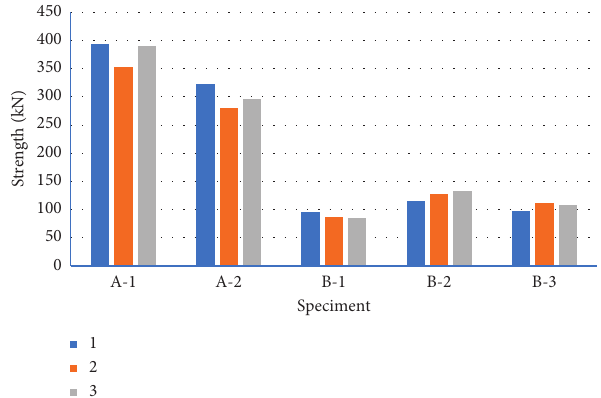
Figure 4: Experimental results of plate and groove embedded parts.